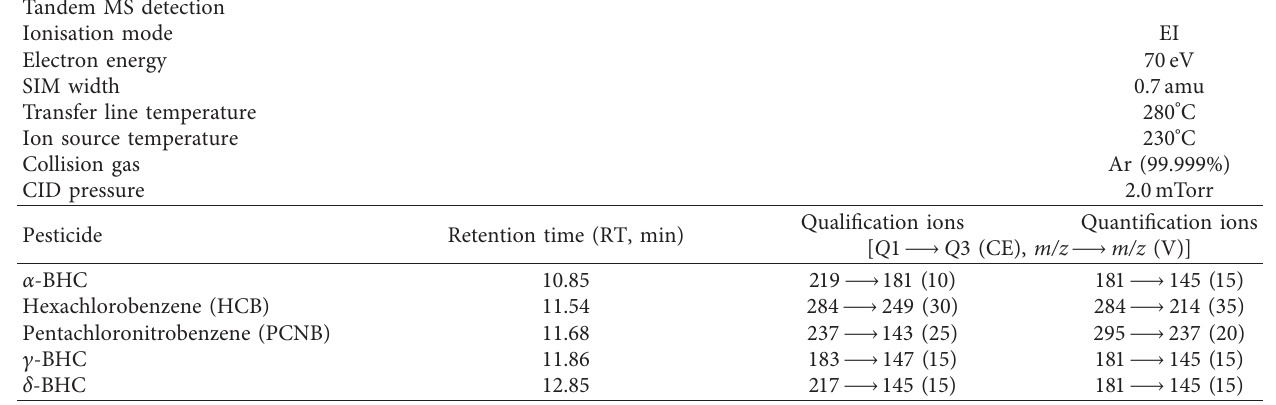
Table 1: Parameters for the determination of five pesticides by